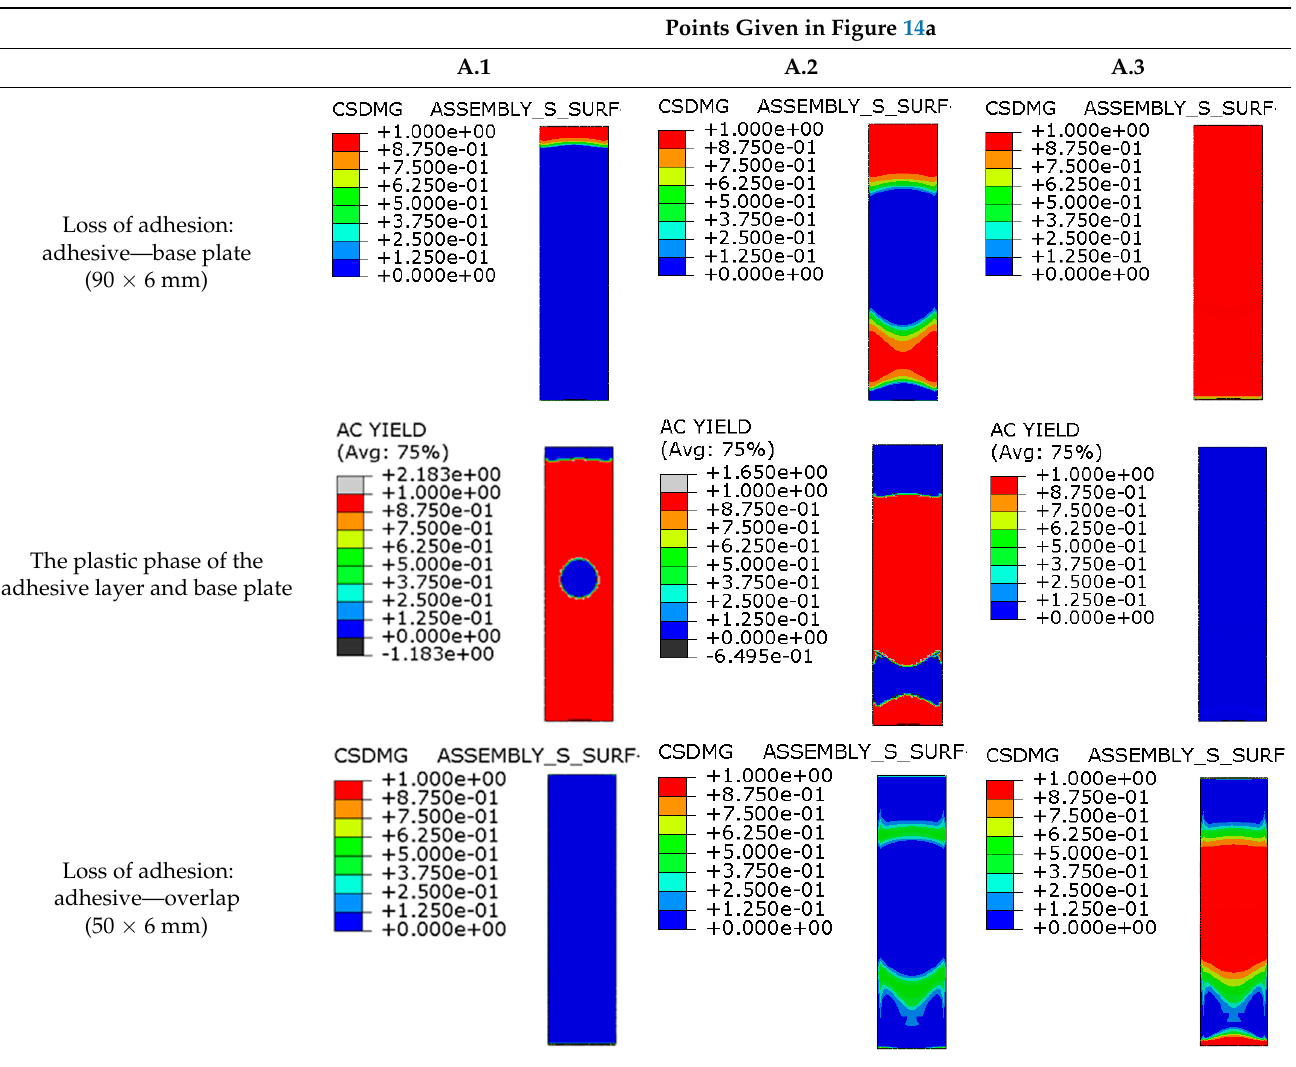
Table 5. Tensile and shear properties of adhesive.